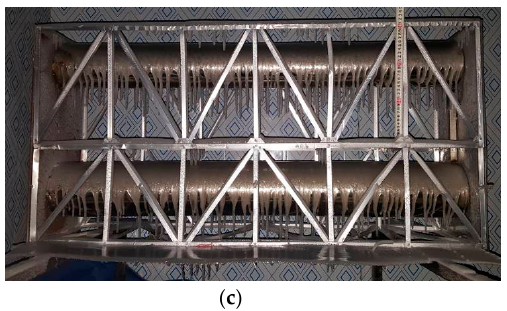
Figure 20. Side views of icing sectional model: ( a ) girder A, ( b ) girder B, and ( c ) girder C.